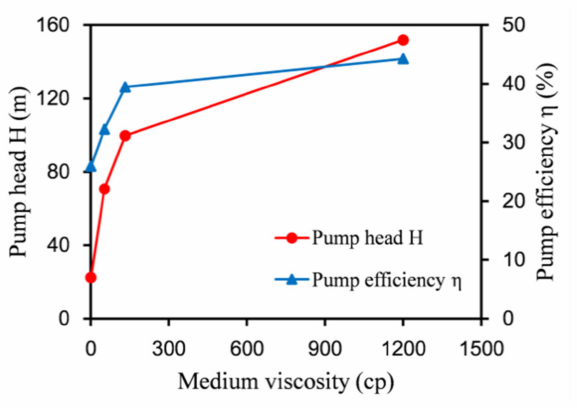
Figure 14. Performance comparison of labyrinth pumps at the best working point under different vis-